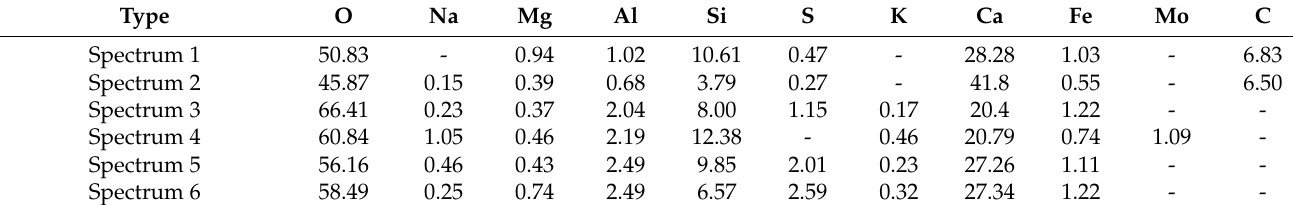
Table 12. Results of EDS analysis of tunnel cavity slag concrete.